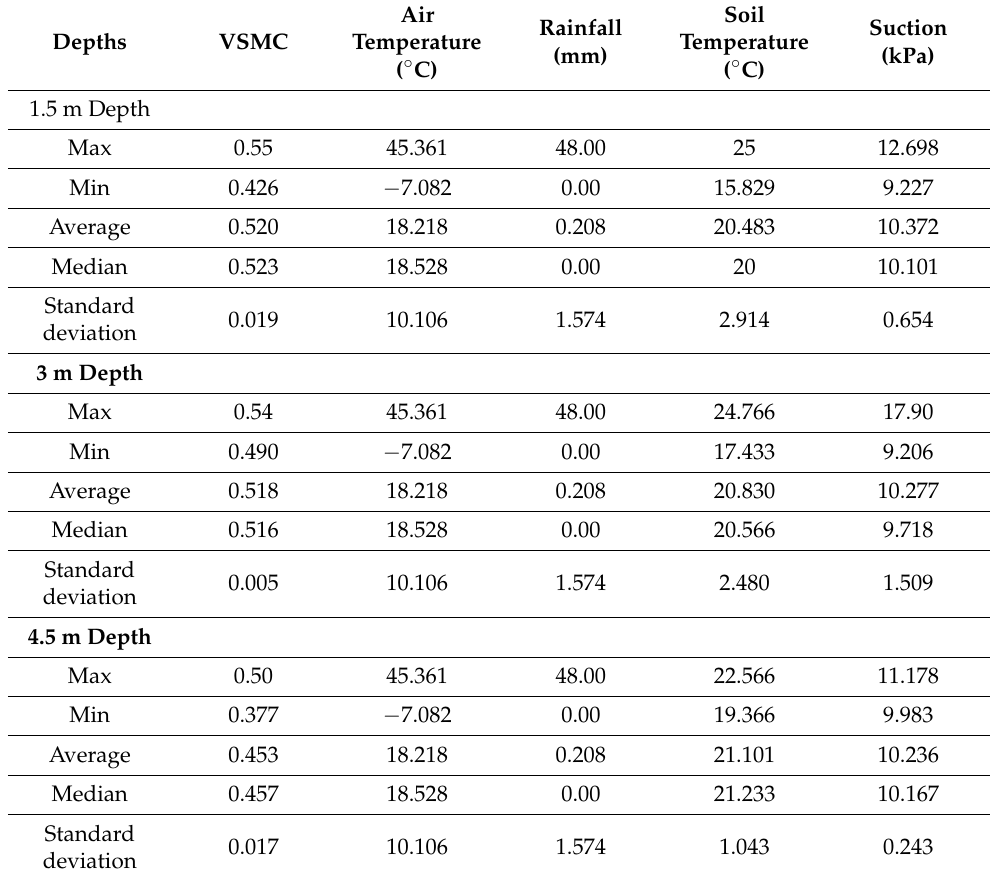
Table 1. Preliminary detailed statistics for the constructed dataset for HWS 1.